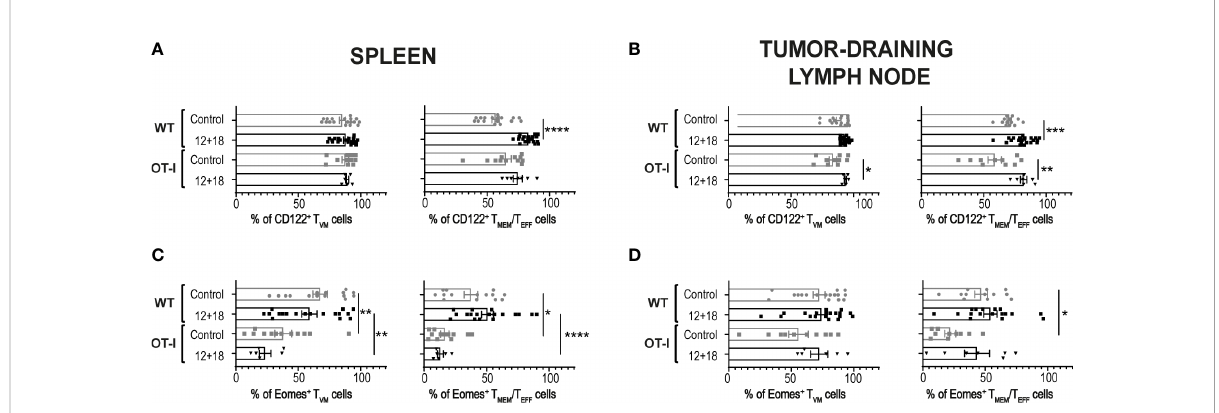
FIGURE 6 Effects of systemic co-expression of IL-12 plus IL-18 on T VM and T MEM /T EFF cells in SLO from WT or OT-I mice. OVA neg B16-bearing C57BL/6 WT or OT-I mice were hydrodynamically injected (HI) with IL-12 plus IL-18 cDNA (12 + 18) or empty cDNA as the control. After 7 days post-HI mice were euthanized, and spleen and tumor-draining lymph nodes (dLN) were harvested and processed for fl ow cytometry. Bar graphs show the frequencies of (A, B) CD122 + or (C, D) Eomes + T VM or T MEM /T EFF cells (left and right graphs respectively) on (A, C) spleen and (B, D) dLN from each experimental group. Statistical analysis was performed with One-Way ANOVA (A, D, left B, and left C) or Brown-Forsthy and Welch ANOVA test (right B and right C). Values of *p<0.05, **p<0.01, ***p<0.001, ****p<0.0001 were consider signi fi